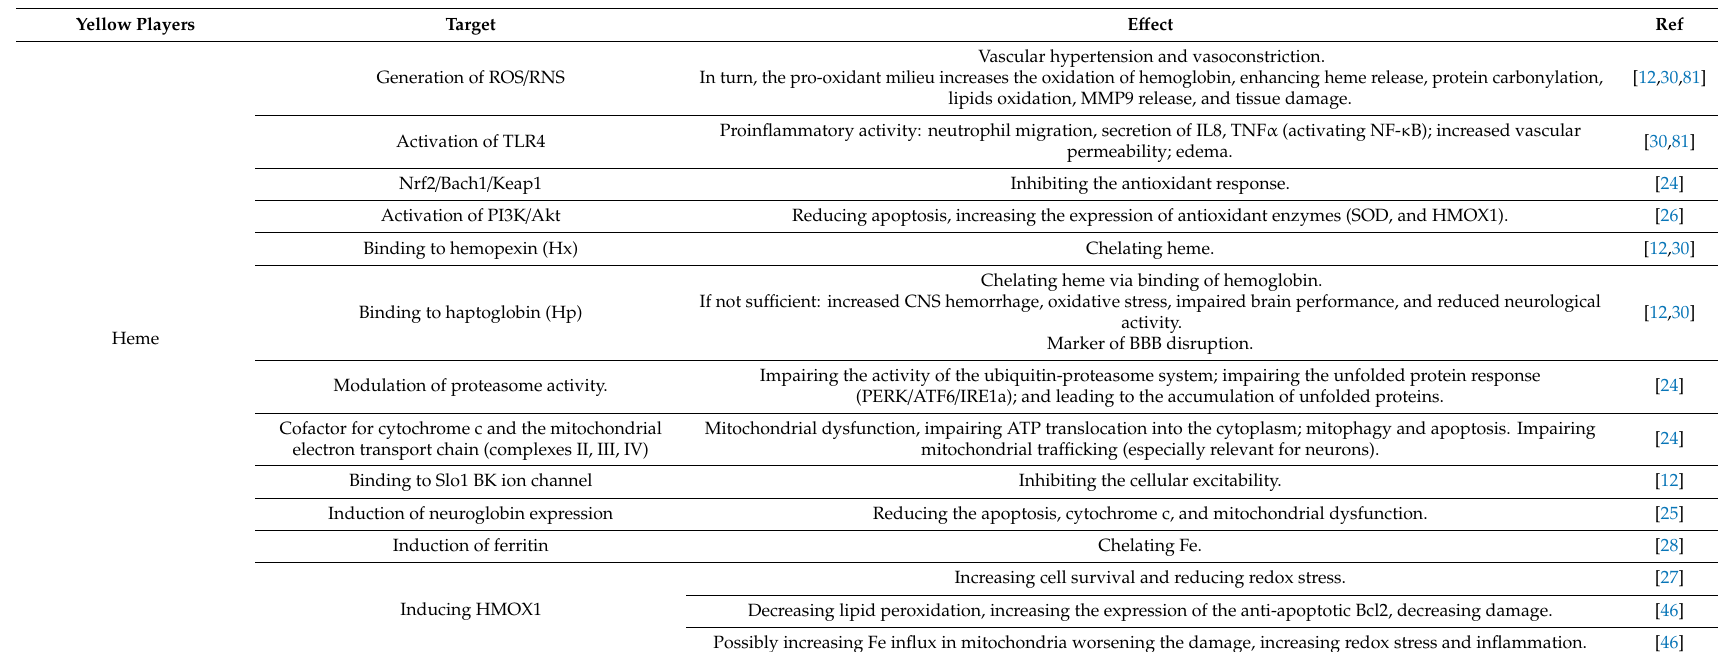
Table 2. The YPs and their molecular